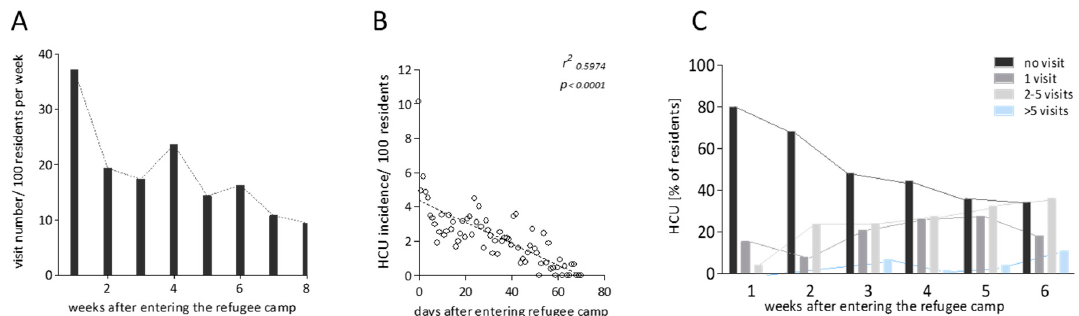
Figure 4. Time of refugee center inhabitance influences health care utilization. ( A ) Healthcare utilization rates per 100 camp residents per week after entering the shelter. ( B ) Correlation of healthcare utilization rates per 100 residents with residence duration in days. ( C ) Overall healthcare utilization depending on personal week of stay at the center (HCU: healthcare utilization).